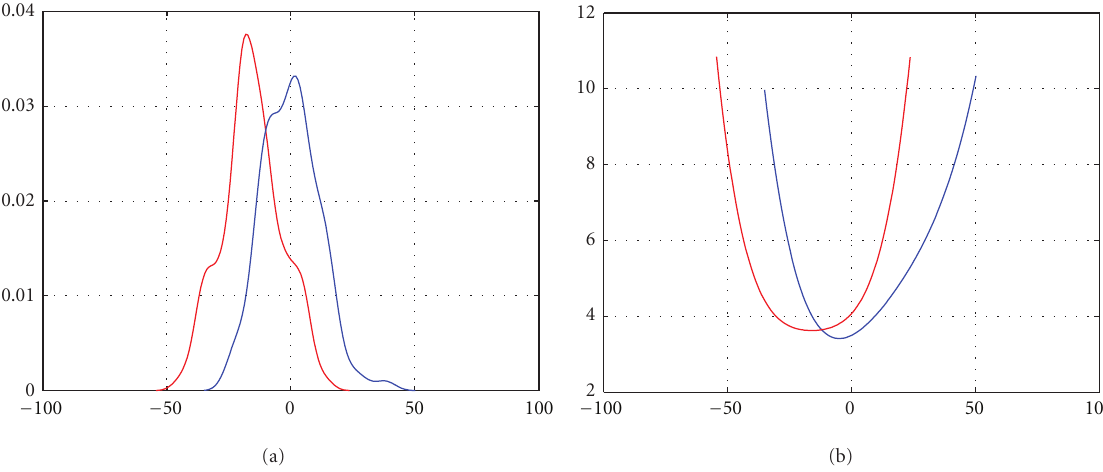
Figure 8: pdfs (a) and potential (b) of the time series of EOF1 for the 20th-century run (blue) and for A1B experiments during years 2080–2179 (red).